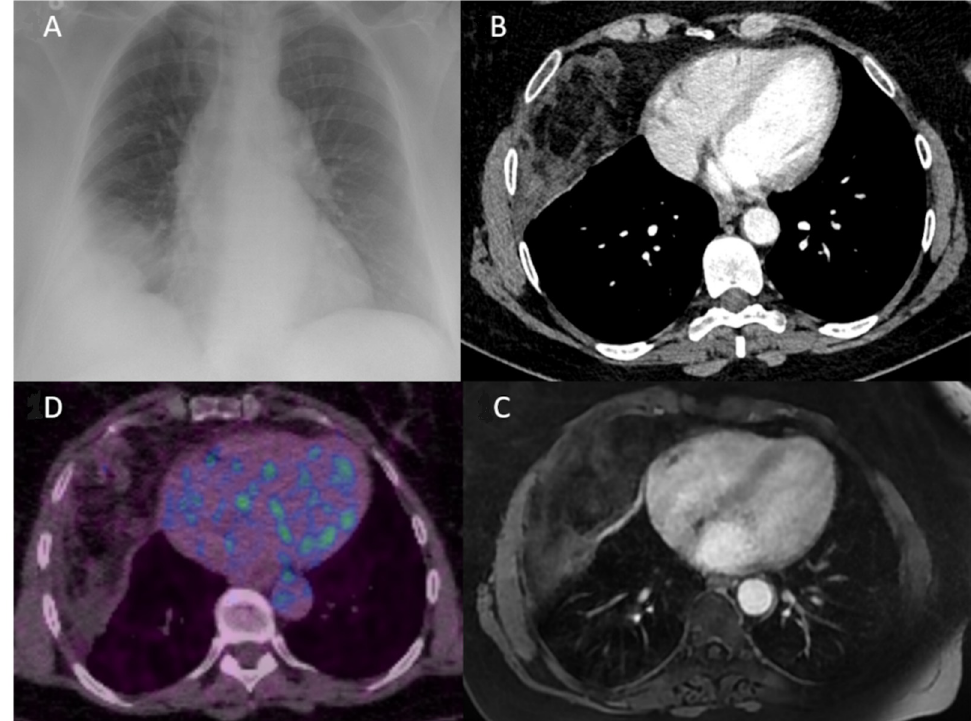
Figure 1. ( A ) Chest X-ray showing a non-systematized opacity of the right costo-diaphragmatic angle making the diagnosis between pleural effusion and thoracic mass difficult. ( B ) CT scan of the chest (axial view) confirming the presence of a heterogeneous intra thoracic mass not appearing to be in the lung parenchyma. ( C ) An axial T1-weighted MR image of the chest identifying a tumorous chest wall mass with both fat and tissue components, suggestive of liposarcoma. ( D ) 18-fluorodeoxyglucose (FDG) positron emission tomography showing a low hypermetabolism of this lesion with a standardized uptake value of 1.8.